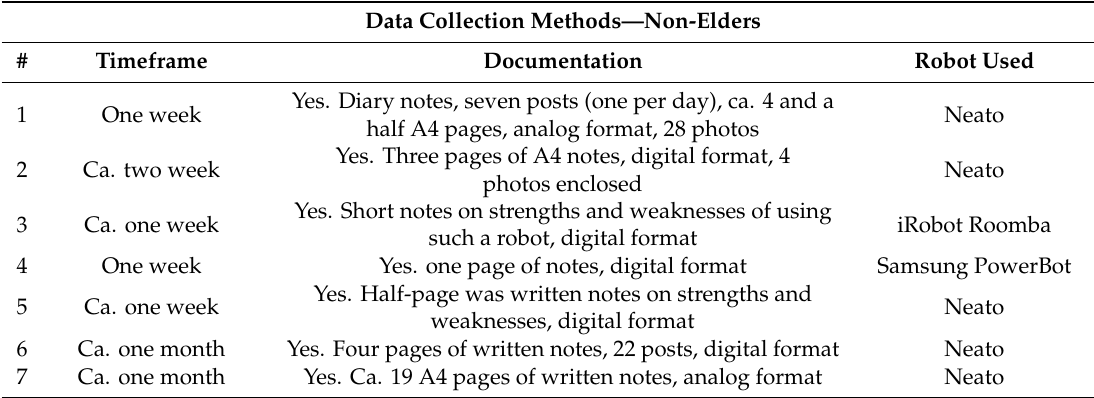
Table 2. Overview of the data collected from non-elders